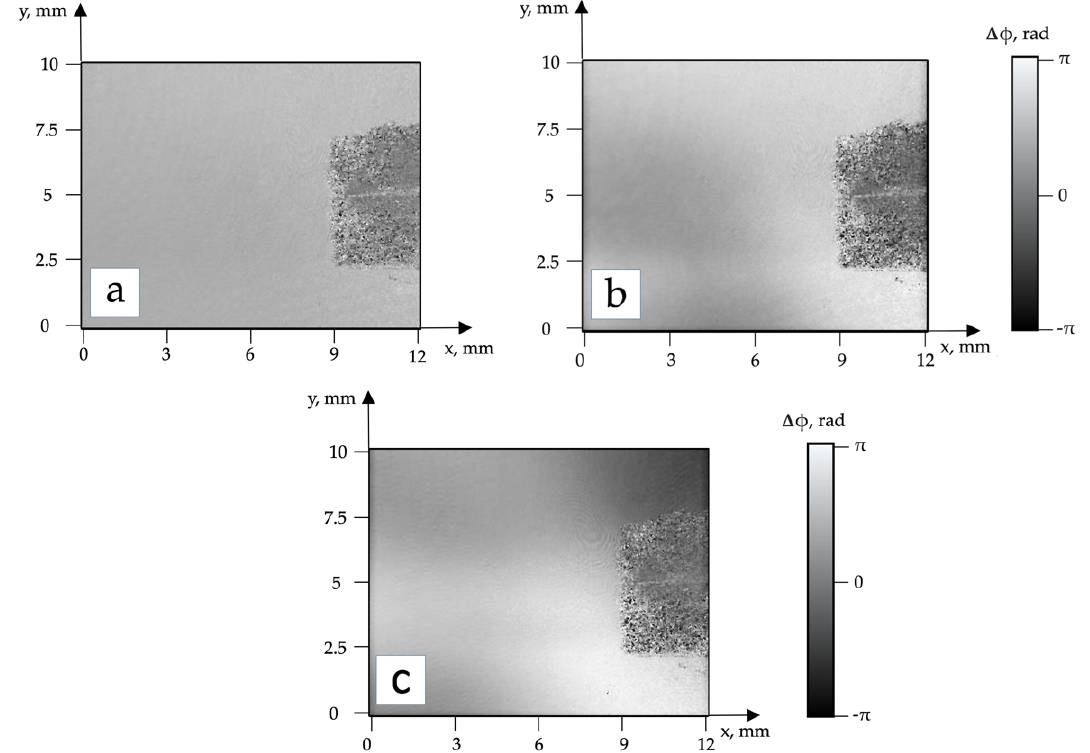
Figure 9. Phase difference: ( a )—phase difference corresponding to the initial state; ( b )—phase difference with plasma; ( c )—phase difference at 700 ns after the end of plasma jet.